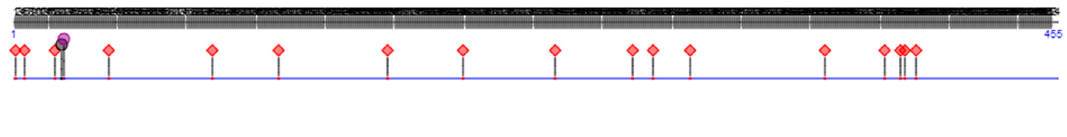
Figure 2. Protein–protein and protein–polynucleotide binding sites. The ‘red triangles’ and the ‘colorful circled shapes’ indicate the protein–protein, and protein–polynucleotide binding sites, respectively.